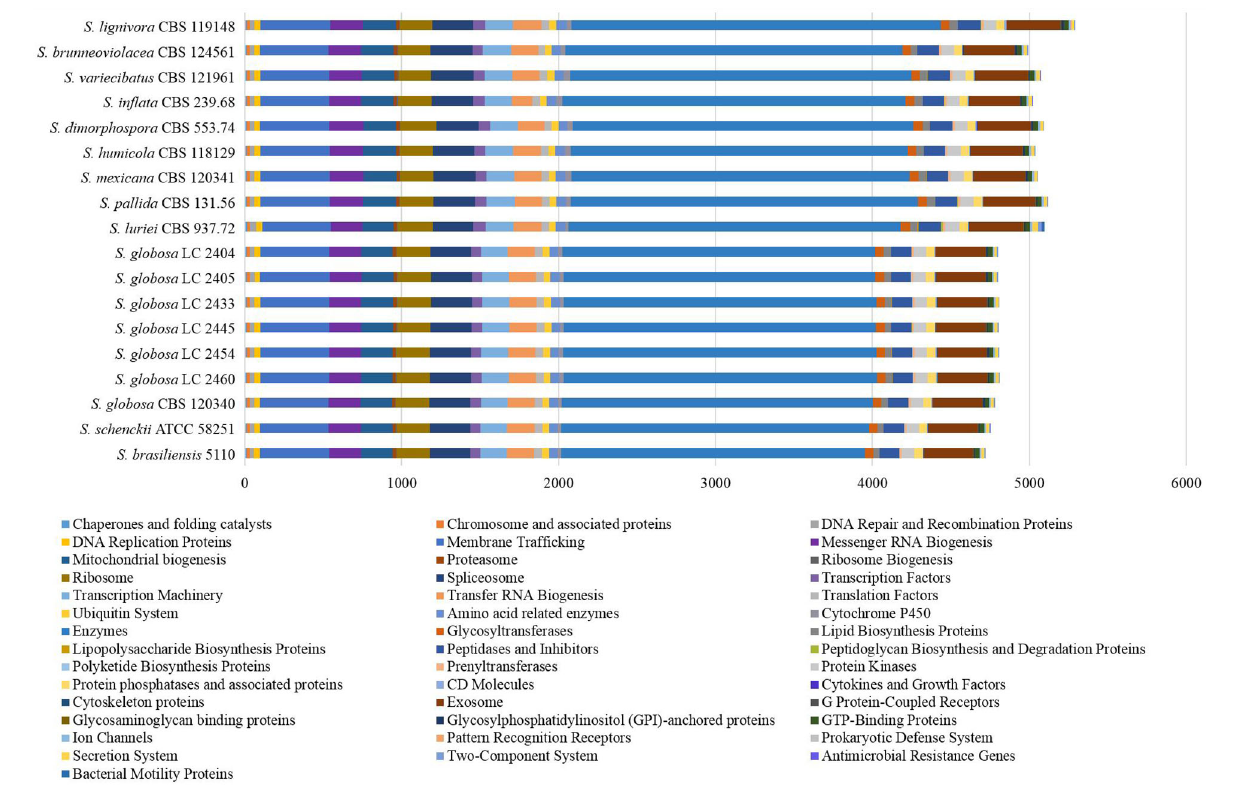
FIGURE 1 | Protein annotation of KEGG database in Sporothrix. All proteins annotated with known function were classified into different categories according to the KEGG database. The core metabolic functions comprised enzymes, exosome, membrane trafficking, messenger RNA biogenesis, mitochondrial biogenesis, ribosome, and